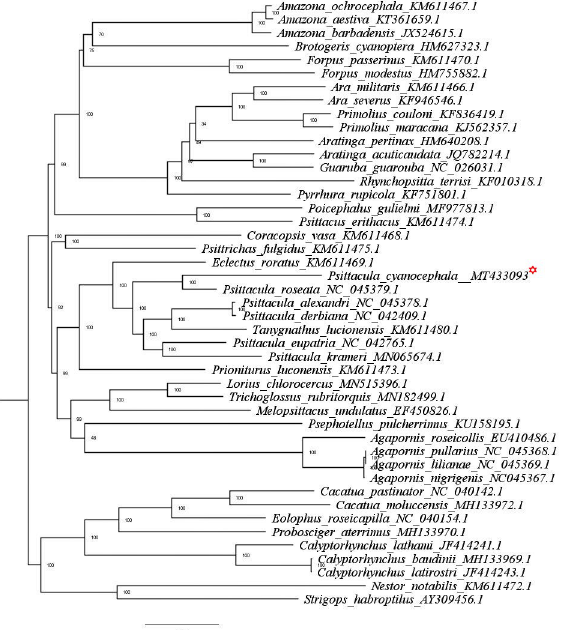
Fig 5. ML tree based on the phylogenetic relationships of 45 Psittaciformes species determined using concatenated nucleotide sequences of 13 mitochondrial PCGs. The tree was constructed in IQ-TREE employing TVM+F+G4 nucleotide substitution model, bootstrapped for 10000 replicates. P . Cyanocephala mitogenome is highlighted with red asterisk mark.